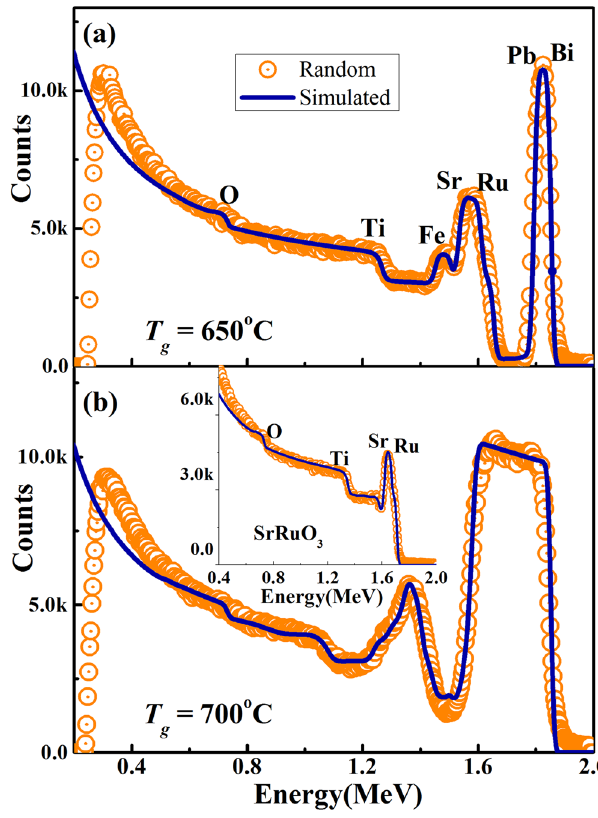
Figure 3. Elemental analysis of each layer of (BiPb)FeO 3 /SrRuO 3 /SrTiO 3 heterostructures and bottom SrRuO 3 / SrTiO 3 structure. RBS simulated data ( solid lines ) for (BiPb)FeO 3 /SrRuO 3 /SrTiO 3 heterostructures of (a) T g = 650 °C and (b) T g = 700 °C are in good agreement with random data (symbols) . Variation in different edges of Pb, Bi and Fe indicate composition and thickness changes with T g . Inset of Fig. 3(b): Random and simulated spectra of bottom SrRuO 3 /SrTiO 3 structure with Ru vacancies at surface of SrRuO 3